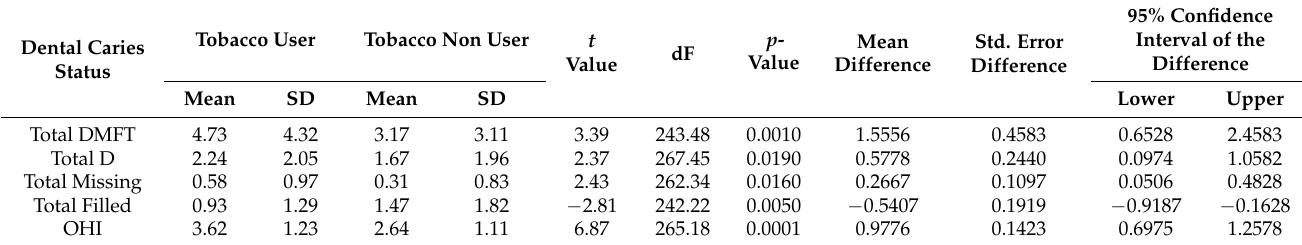
Table 3. Distribution of habit and varying DMFT parameters.